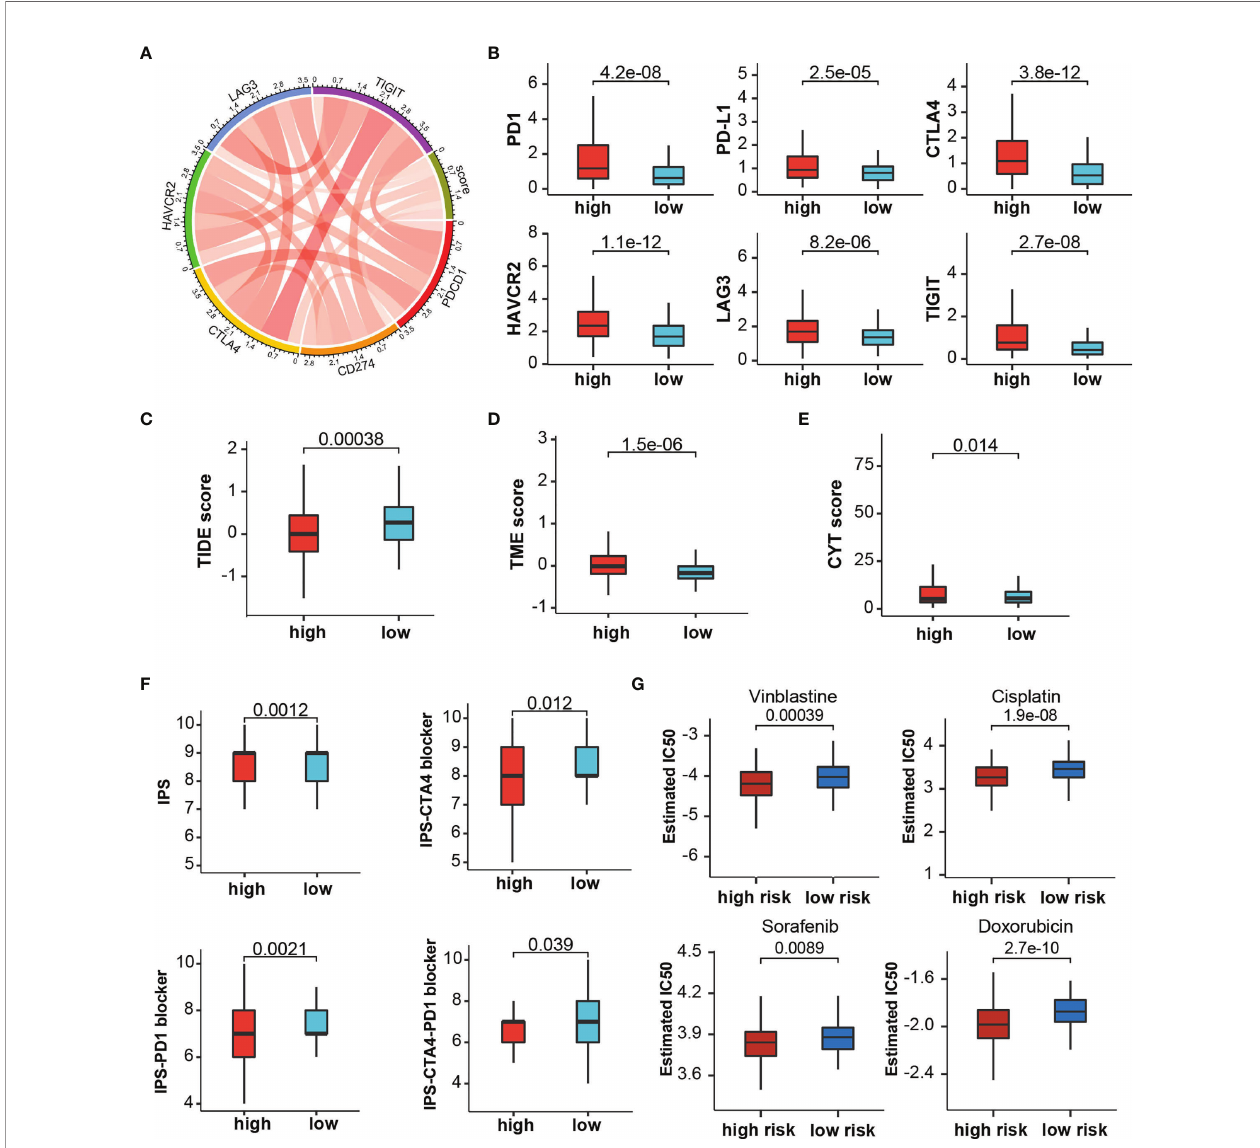
FIGURE 10 | The estimation of Immunotherapy and chemotherapy response. (A) Circos plot showing the correlation between immune checkpoints and the risk score. (B) The expression levels of immune checkpoints between risk strati fi cations. (C – F) The association between risk score and TIDE score, TME score, CYT score, and IPS. (G) The chemotherapy response of two prognostic subtypes for four common chemotherapy